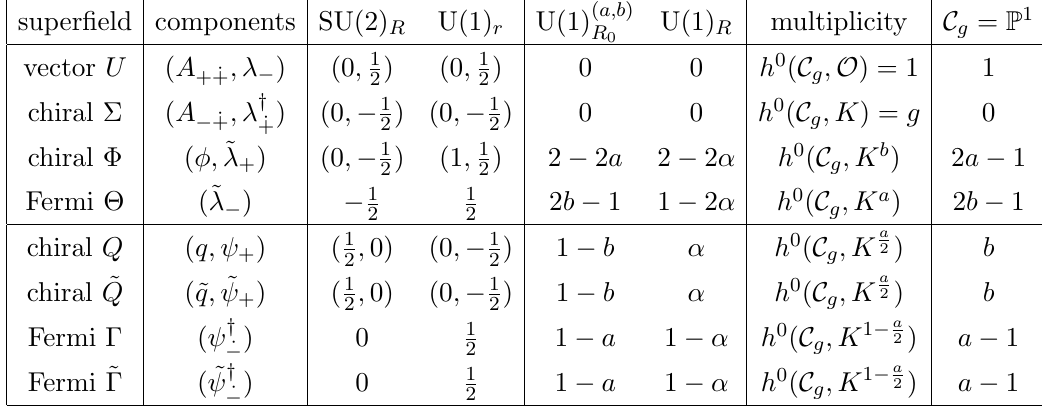
Table 5. Summary of general N = (0 ; 2) twist of 4d N = 2 multiplets. R 0 = 2( aR + br ), R = 2( (cid:11)R + (cid:12)r ) with a + b = 1 ; (cid:11) + (cid:12) =